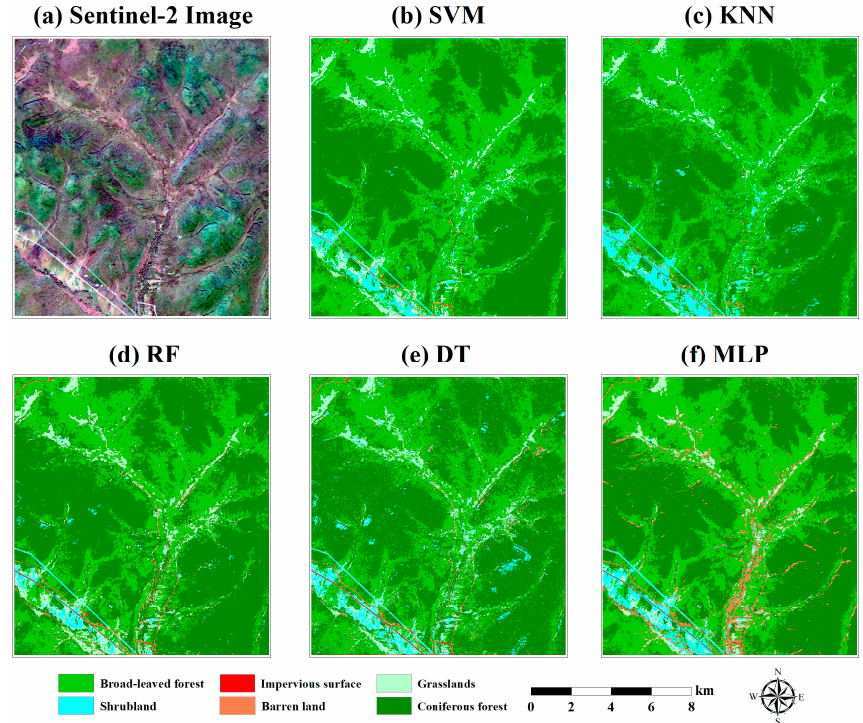
Figure 5. Sentinel-2 remote sensing image ( a ) and forest land resource information maps of the five-classifiers based on Mul-GLCM features: ( b ) SVM classifier; ( c ) KNN classifier; ( d ) RF classifier; ( e ) DT classifier; ( f ) and MLP classifier.